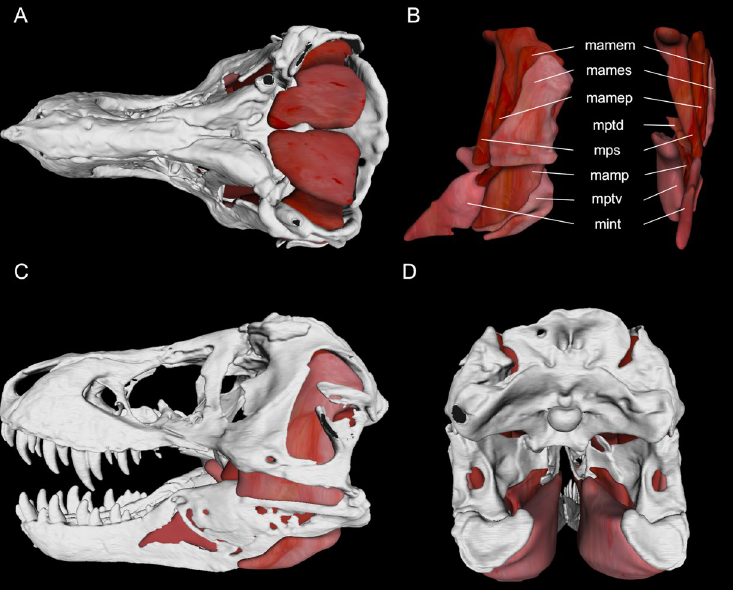
Figure 2. Jaw adductor muscle model for Tyrannosaurus rex (BHI 3033) in ( A ) dorsal, ( C ) left lateral, and ( D ) posterior views. Muscles in anatomical position are figured in ( B ) (lateral view is on left; anterior view is on right), textures and shades based on Alligator mississippiensis 32 . Abbreviations: mamem, Musculus adductor mandibulae externus medialis ; mames, M . adductor mandibulae externus superficialis ; mamep, M . adductor mandibulae externus profundus ; mptd, M . pterygoideus dorsalis ; mps, M . pseudotemporalis complex; mamp, M . adductor mandibulae posterior ; mptv, M . pterygoideus ventralis; mint, M . intramandibularis